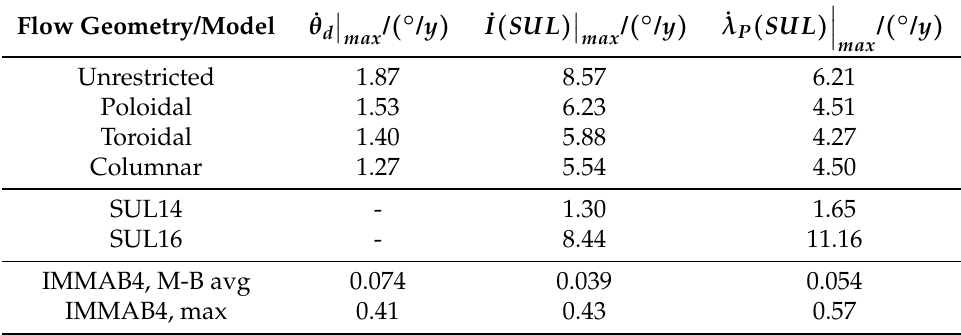
Table A1. Numerical values of ˙ θ d , ˙ I ( SUL ) and ˙ λ P ( SUL ) for optimal flow calculations (indicated by the different flow geometries) with T 0 = 13 km/y, from the measurements at Sulmona (SUL14 and SUL16) and from the IMMAB4 geomagnetic field model. The optimal values reported here are the maxima from the time series illustrated in Figure A2a. Values indicated with “IMMAB4, M-B avg” values were obtained by calculating differences between points at the beginning and at the end the M-B transition. Values indicated with “IMMAB4, max” refer to the maximum rates of change calculated via first differences. See the main text (Sections 1 and 5) for